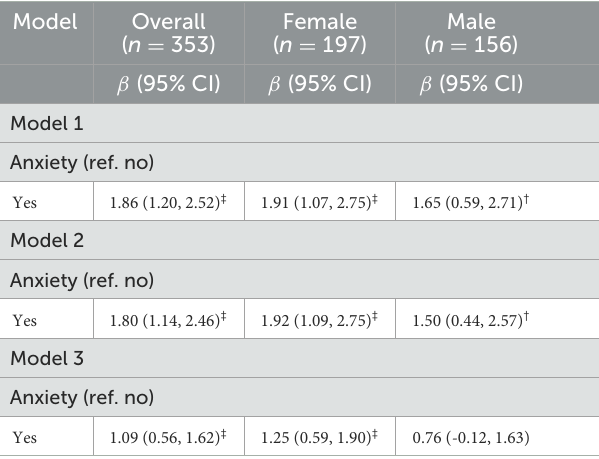
TABLE 2 Association between anxiety and frailty. TABLE 3 Interaction effect of anxiety and outdoor activity spaces on